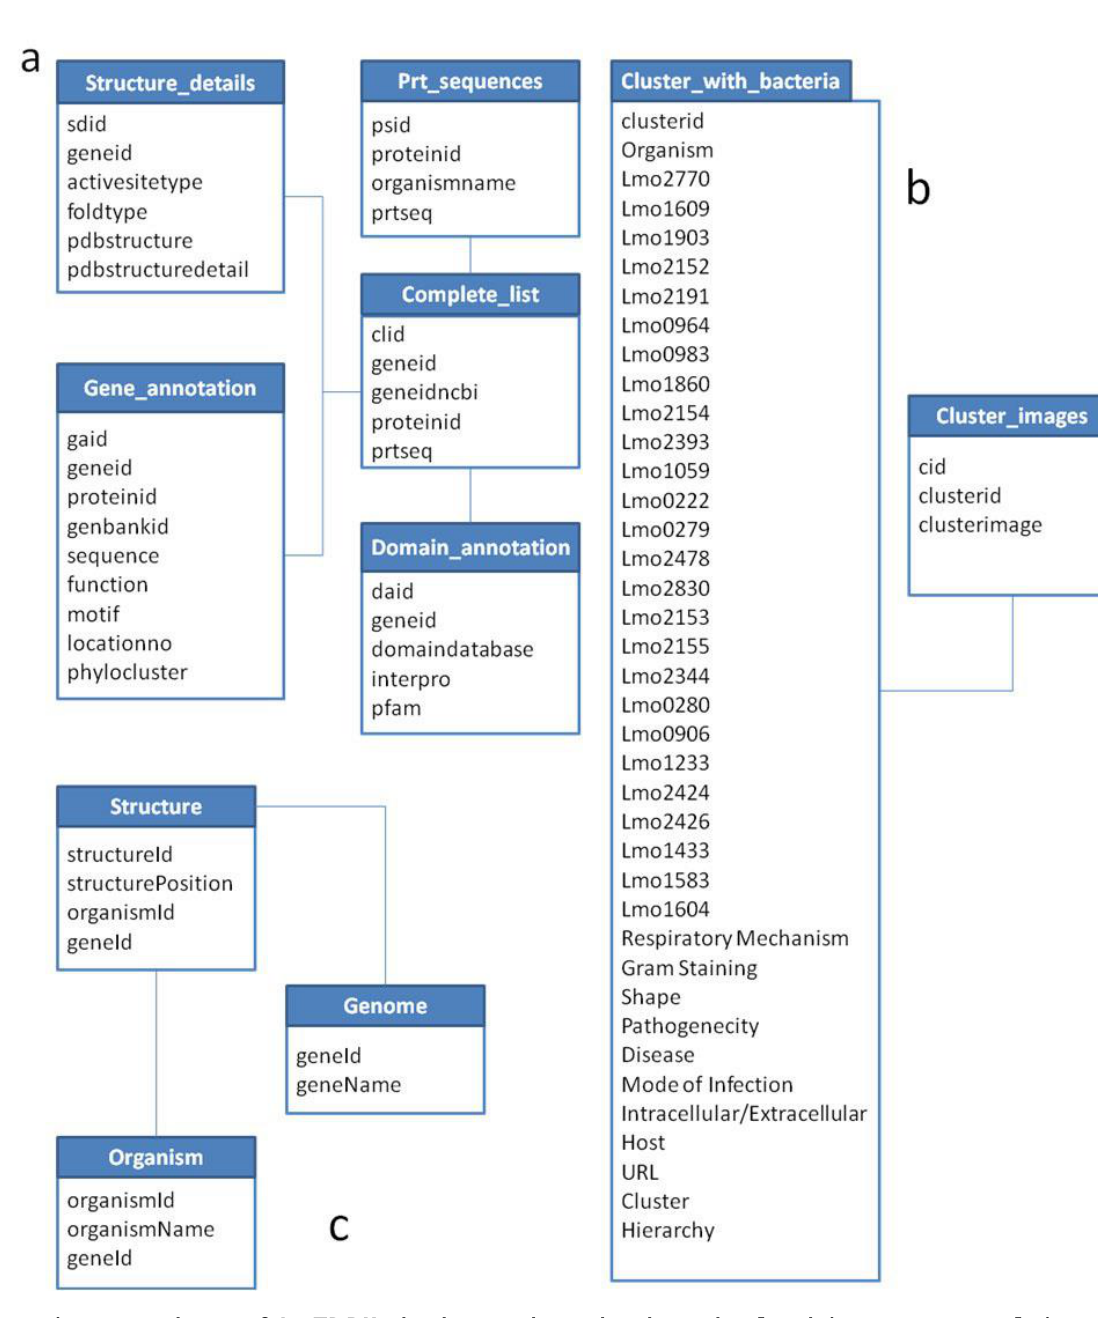
Figure 4: Schema of LmTDRM database. Schema has been developed in 3 parts. a. Relative tables for search. b. Relative tables for TDRM analysis. c. Relative tables for genome